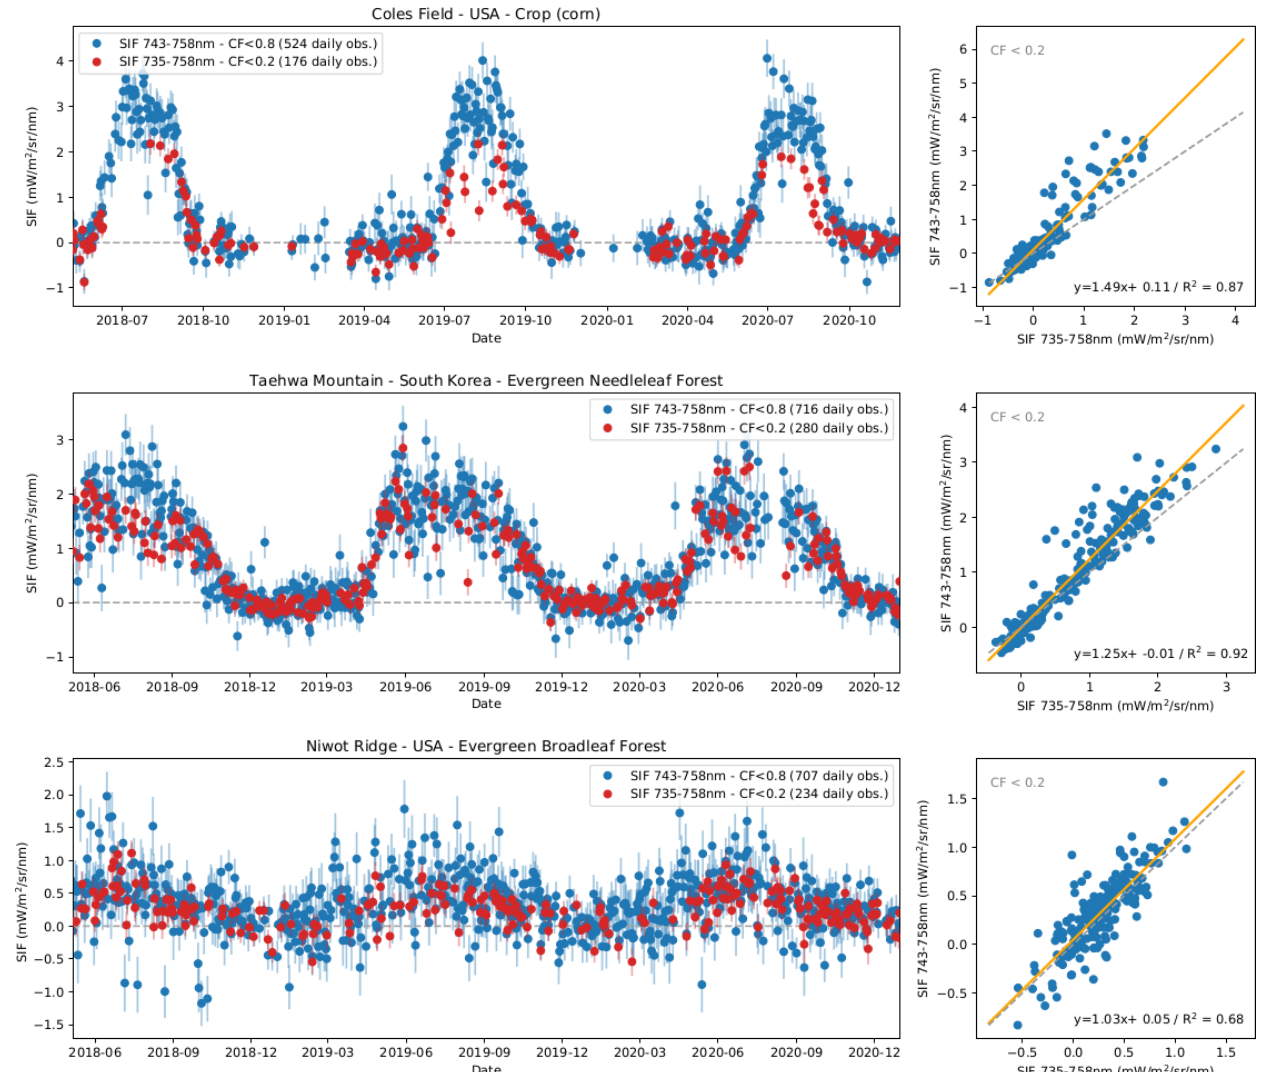
Figure 8. Comparison of SIF retrievals from the 743–758 and 735–758nm fitting windows and 0.2 and 0.8 cloud fraction (CF) thresholds at three sites (0.1 ◦ radius) corresponding to different biomes (Parazoo et al., 2019). Left: time series of the daily SIF retrievals for two combinations of fitting window and cloud screening (743–758nm data with CF < 0.8 and 735–758nm with CF < 0.2) from May 2018 to December 2020. The vertical bars are the averaged 1 σ retrieval errors. Right: scatterplot between 735–758 and 743–758nm retrievals for CF < 0.2. The coefficient of determination R 2 and the linear regression equation are